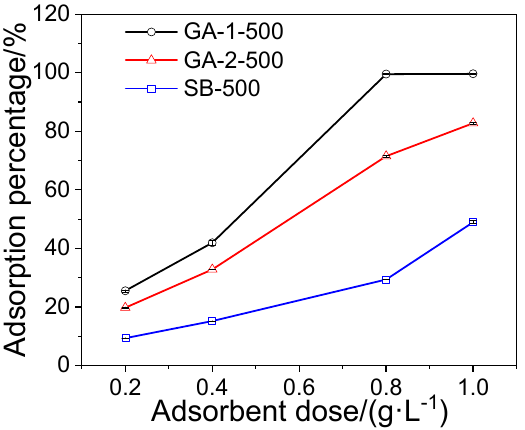
Figure 6. Effect of adsorbent dosage on phosphorus adsorption percentage. Figure 6. E ff ect of adsorbent dosage on phosphorus adsorption